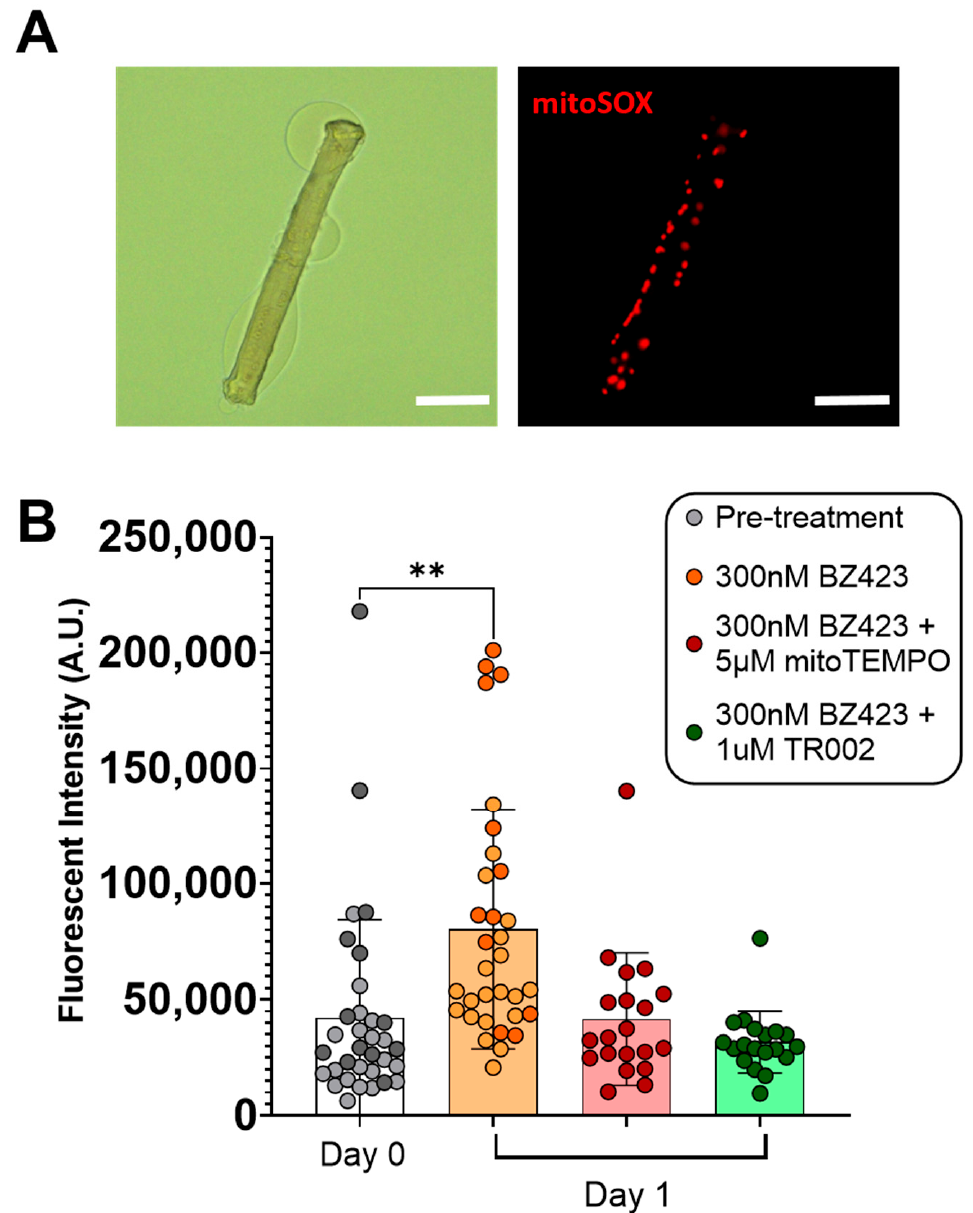
Figure 2. To examine the impact of chemical induction of MPT on mROS emission, single isolated myofibers were treated with either 300 nM Bz423, 300 nM BZ423 + 5 µ M mitoTEMPO (to scavenge ROS), or 300 nM BZ423 + 1 µ M TR002 (to inhibit MPT) for 24 h, and mitoSOX signal was determined at baseline and post-treatment. ( A ) Representative brightfield and fluorescence images of single FDB muscle fibers following 24 h treatment with Bz423. Scale bars represent 100 µ m. ( B ) Both mitoTEMPO and TR002 prevented an increase in mitoSOX fluorescence over the 24 h treatment period, while fluorescence increased following treatment with BZ423, indicating an increase in mROS emission. Biological replicates are identified by data points of different colors within a given treatment, while technical replicates share the same color data point. n = 2 biological replicates were used for pre-treatment and 300 nM Bz423-treated myofibers, while n = 1 biological replicate was used for all other groups. ** p < 0.01 versus Day 0.